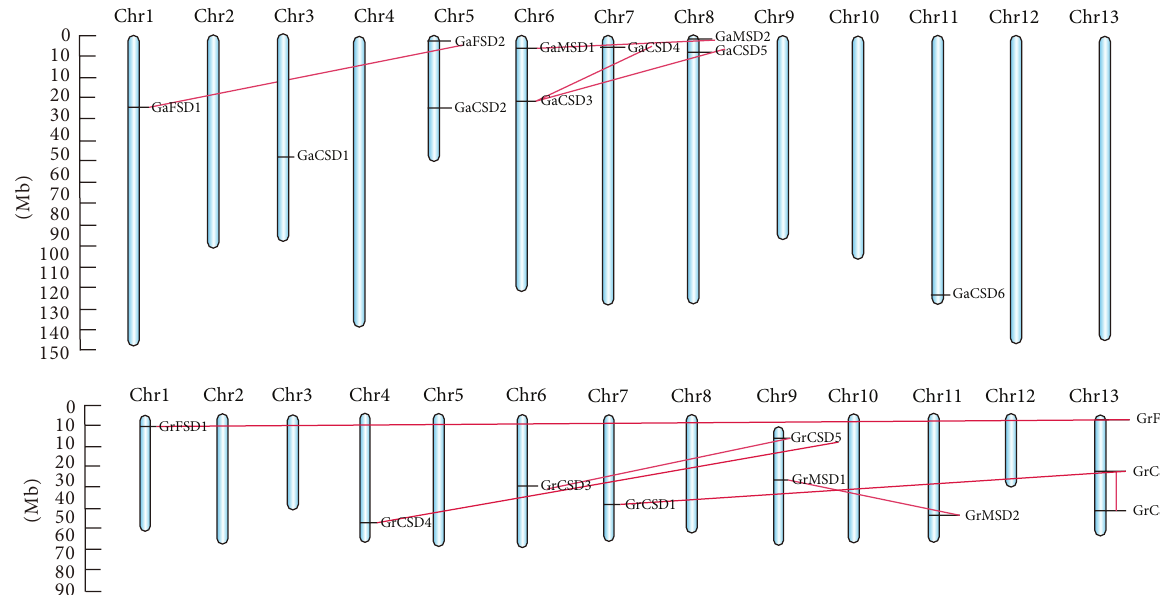
Figure 2: Chromosomal distribution and gene duplication of SOD genes in G. arboreum and G. raimondii . The scale is in megabases (Mb). The chromosome numbers are indicated at the top of each chromosome. The paralogous SOD genes are connected with a red